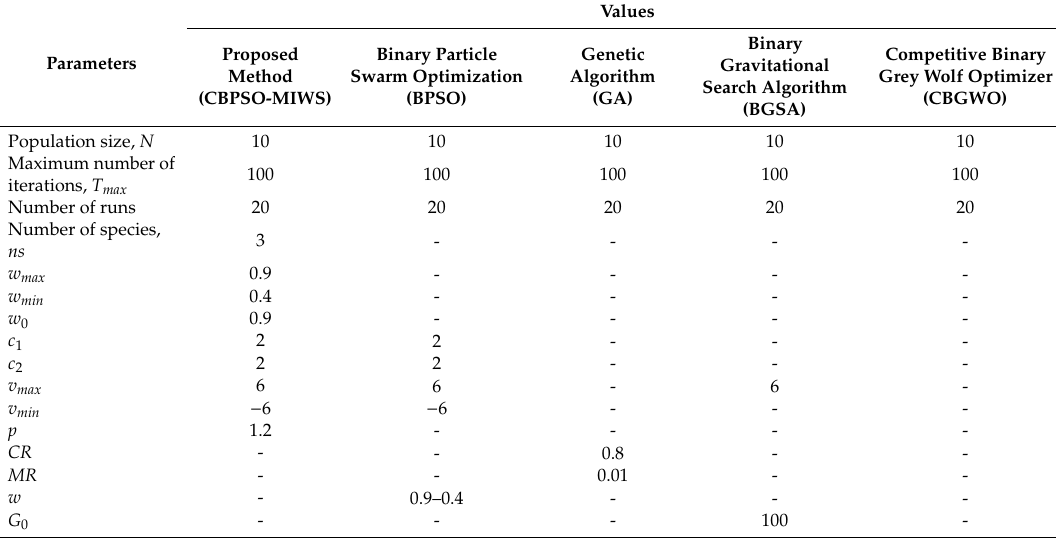
Table 2. Parameter setting of BPSO, GA, BGSA, CBGWO and CBPSO-MIWS.